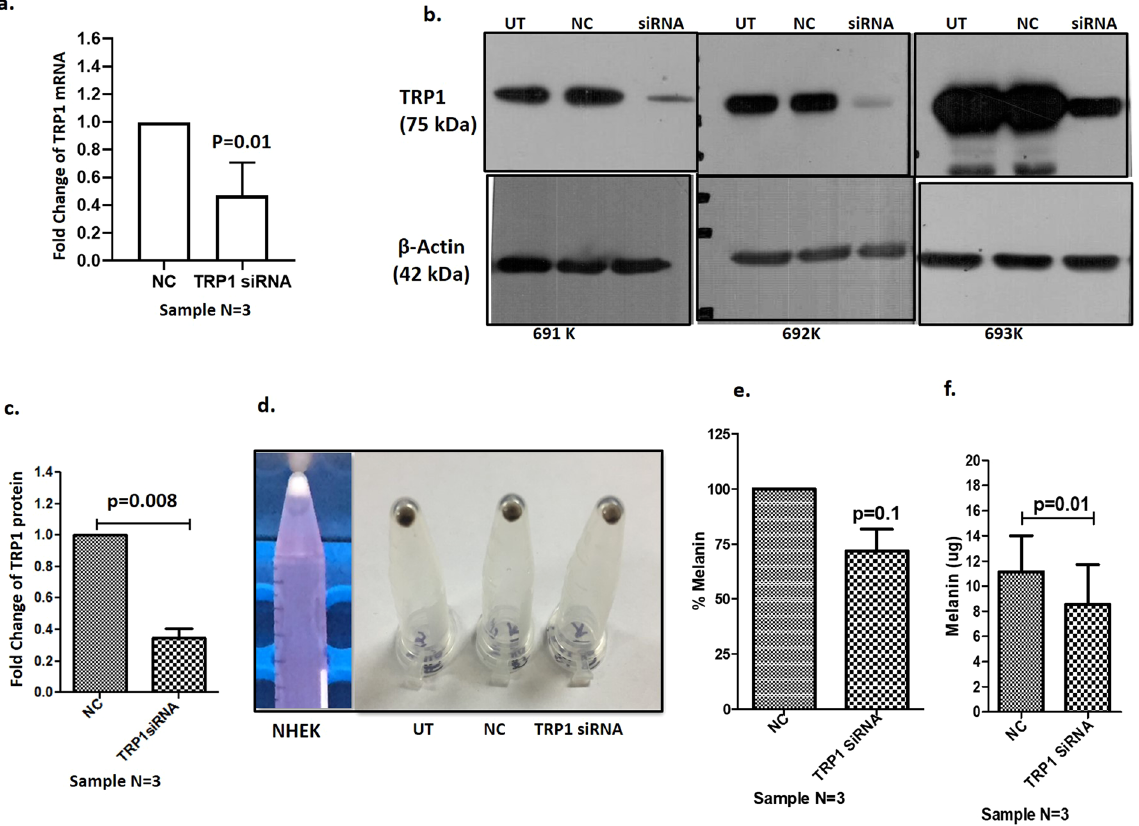
Figure 7. Melanosome transfer from melanocytes to TRP1 siRNA transfected keratinocytes. ( a ) Transcriptional expression of TRP1 in Normal human epidermal keratinocytes (NHEKs) transfected with TRP1 siRNA in 3 samples compared with scrambled control (NC). ( b ) Western blots for expression of TRP1 protein in the same 3 NHEK samples transfected with TRP1 siRNA (full gel pictures are shown in Supplementary Fig. 20. ( c ) Densitometric plots for TRP1 expression as compared with NC normalized with endogenous control β -Actin, confirm downregulation of TRP1 in siRNA transfected keratinocytes. ( d ) Representative image for pellet color in pure keratinocytes, TRP1 siRNA transfected keratinocytes that were co-cultured with melanocytes and harvested by differential trypsinization. Pellet color of keratinocytes transfected with siRNA and co-cultured with melanocytes, is lighter as compared to the keratinocytes transfected with scrambled control (NC) co-cultured with melanocytes. ( e , f ) Bar graphs showing percentage decrease in melanin and total melanin content in keratinocytes transfected with siRNA compared with that of keratinocytes transfected with scrambled control after co-culture with melanocytes. The melanin content in TRP1 siRNA transfected keratinocytes co-cultured with melanocytes was reduced from 100% (11.13 ± 2.87 µ g) in NC to 71.68 ± 10.06% (8.53 ± 3.19 µ g). While there is about 29% decrease, the percent decrease does not show statistically significant difference since for all the samples the reduction was calculated from 100%. However, absolute melanin content clearly shows significant reduction in melanin content in siRNA transfected